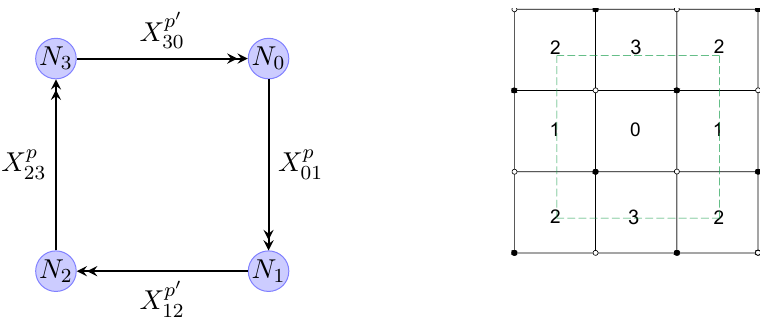
is shown on the left, while the corresponding 2